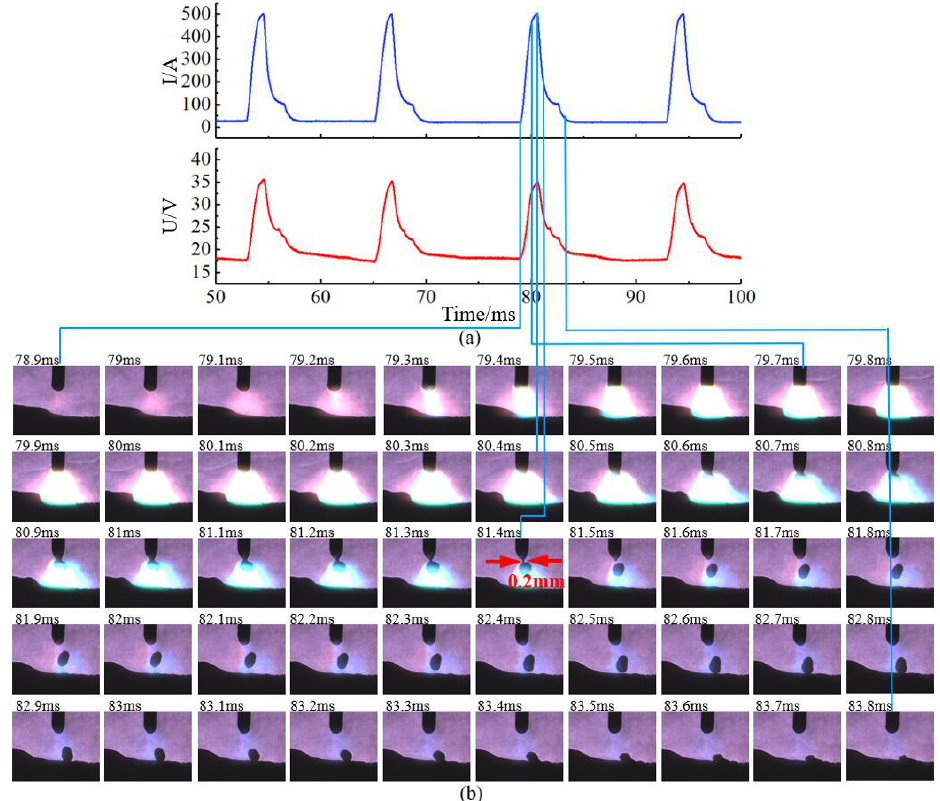
Figure 13. P-GMAW current and voltage signal and arc and droplet transition behavior photographs (exponential pulse waveform, I = 100 A): ( a ) current and voltage signal; ( b ) synchronous